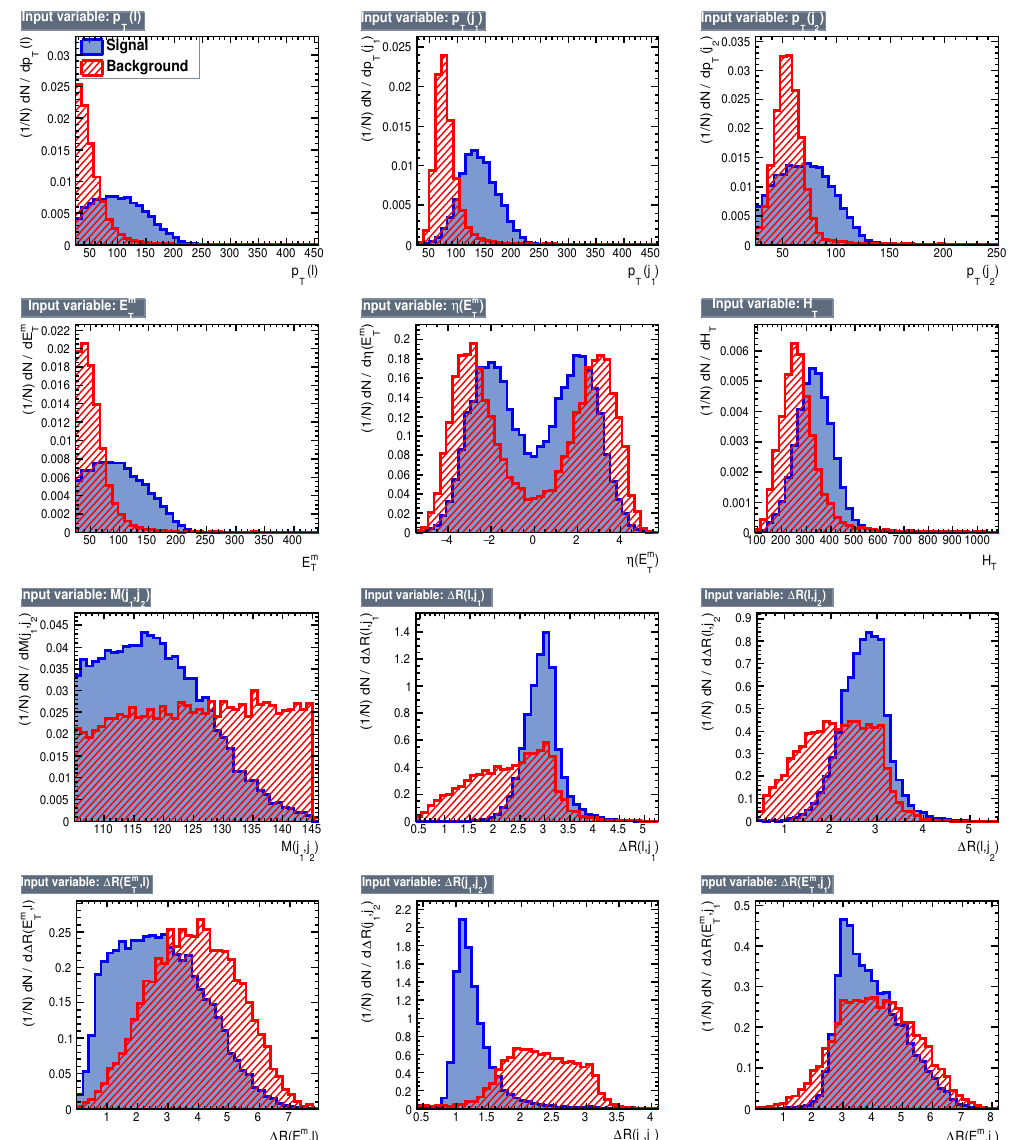
Figure 3 . The same as (cid:12)gure 2 but for m